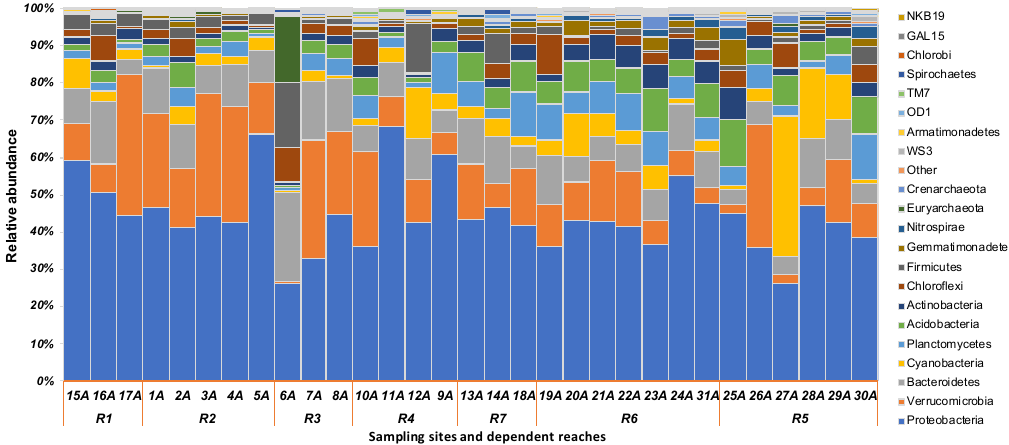
Figure 3. Taxonomic composition distribution of each sample at the phylum level. Only phyla with relative abundance > 0.10% are shown.